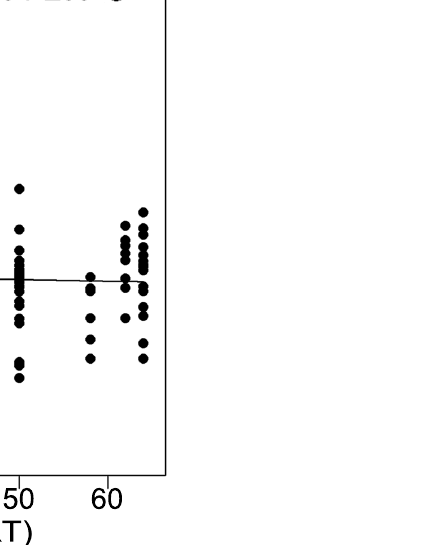
Figure 6. The 3B3-PE38 mediated killing of vRNA producing cells leads to a more rapid reduction in vRNA levels versus ART only. The single Lowess curve for all data points in Fig. 3C (closed symbols; solid line) is graphed together with the combined tissue data for ART + 3B3-PE38 (open symbols; dashed line) to reveal the alteration in cell-associated vRNA levels over time due to the immunotoxin. The beginning of the plateau phase of decay (Day 28) is the divergence point.